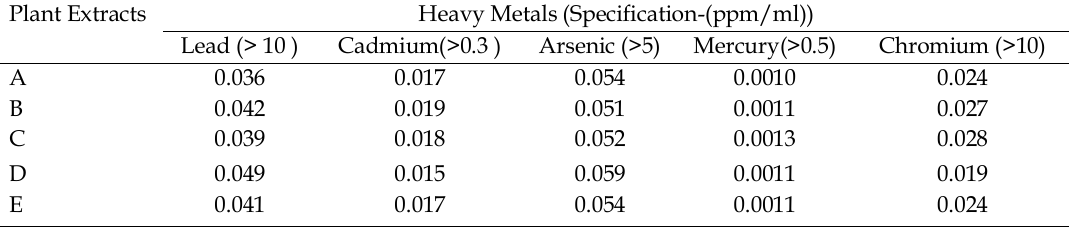
Table 5. Heavy metal content of N. arbor-tristis, H. salicifolia, O. tenuiflorum and R. indica . A=N. arbor-tristis, B=H. salicifolia, C=O. tenuiflorum, D=R. indica, E=Combined herb